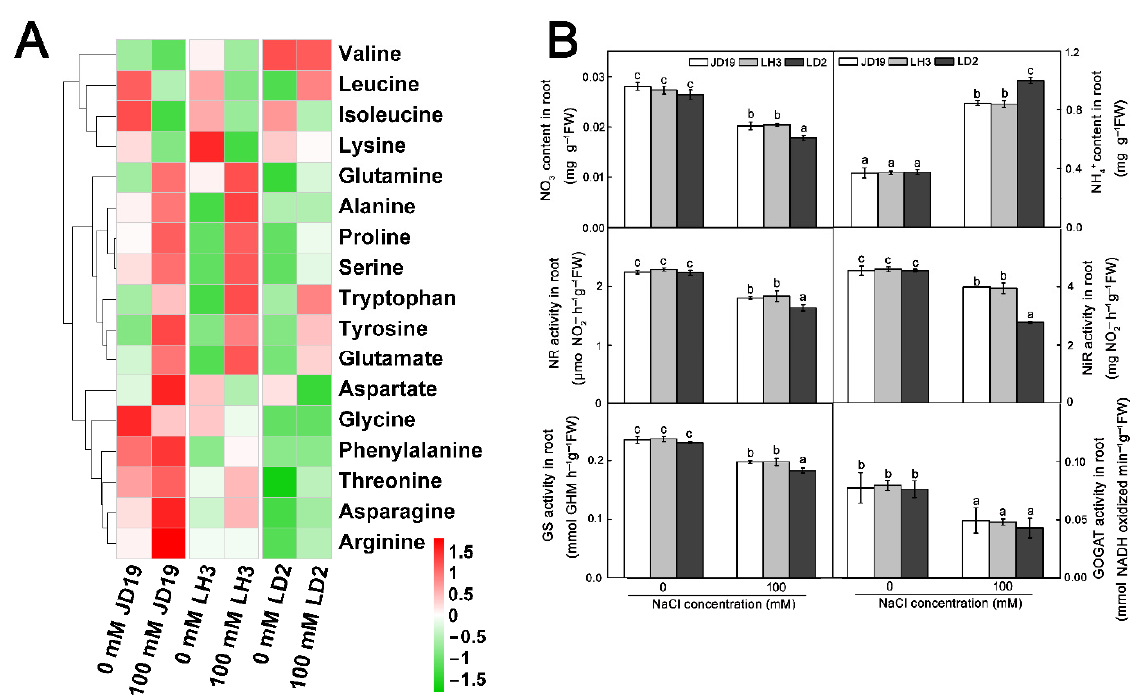
Figure 7. Effects of salt stress on free amino acid contents ( A ) and N metabolism-related enzymes activities ( B ) of three soybean cultivars. Data are means ± SE (n = 3). Different letters indicate significant difference at p < 0.05.